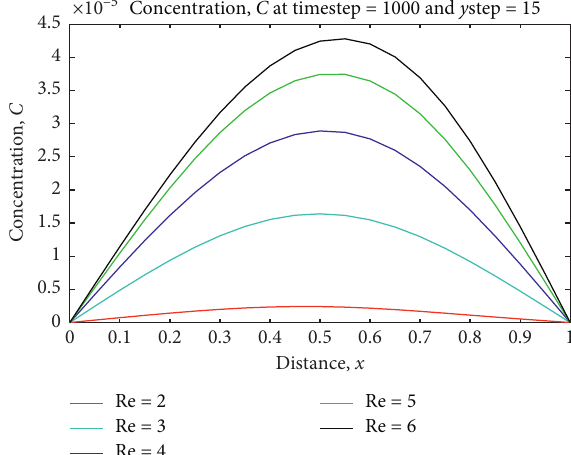
Figure 12: Effects of Reynold number on concentration profile.